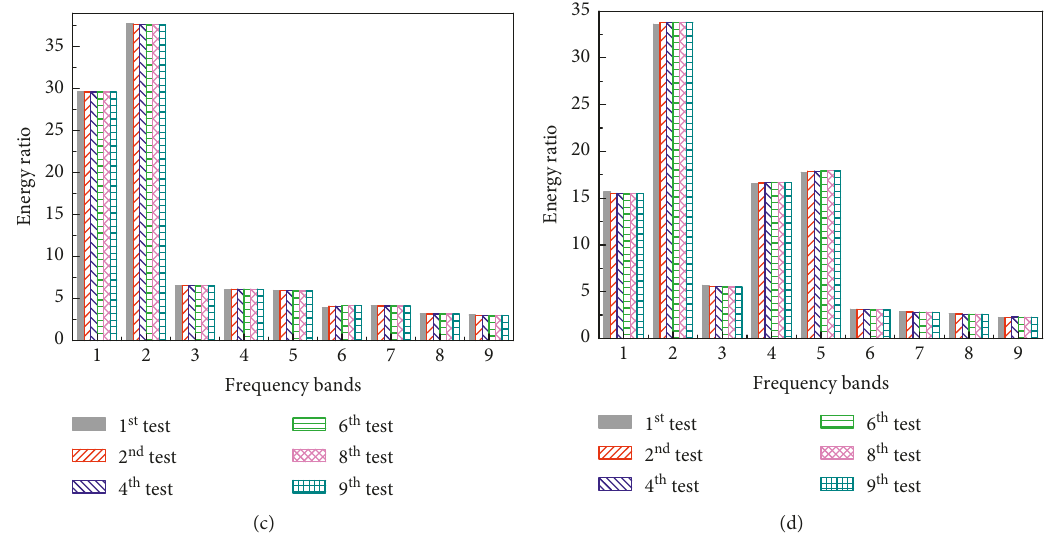
Figure 21: Hilbert marginal energy ratio spectrum in field tests. (a) Point 1. (b) Point 2. (c) Point 5. (d) Point